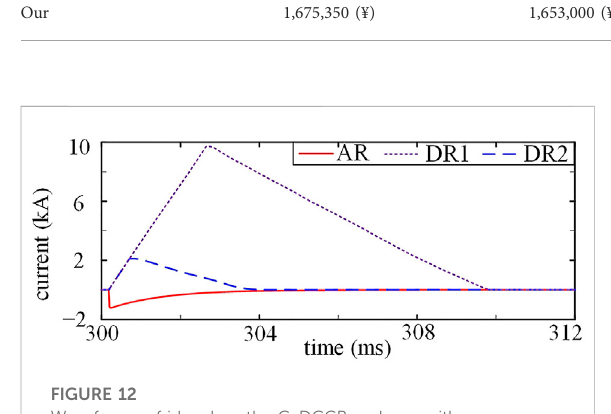
FIGURE 12 Waveforms of idc when the C-DCCB recloses with a permanent fault using different reclosing strategies.